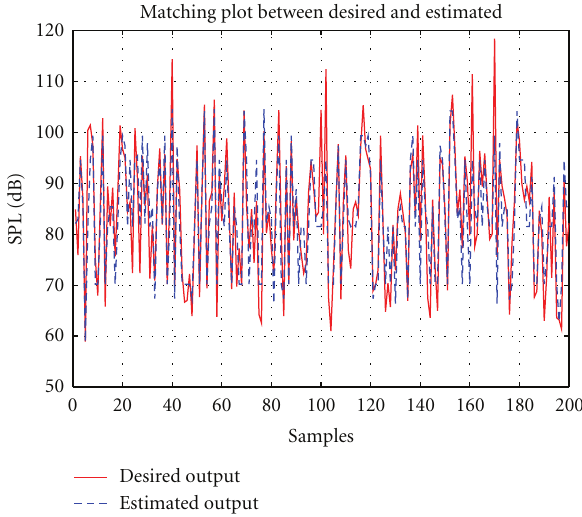
Figure 6: Prediction performance of FLANN system for 200 samples.